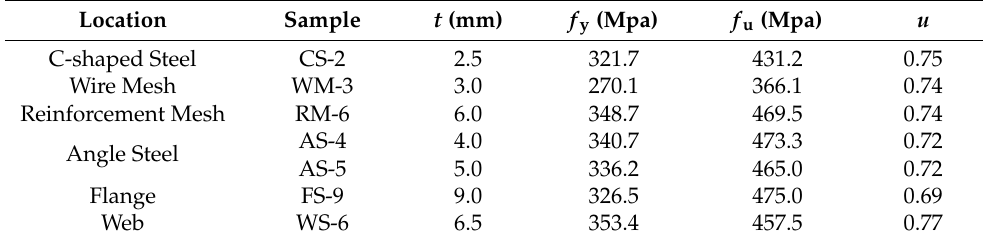
Table 2. The material properties of the steel as used here.